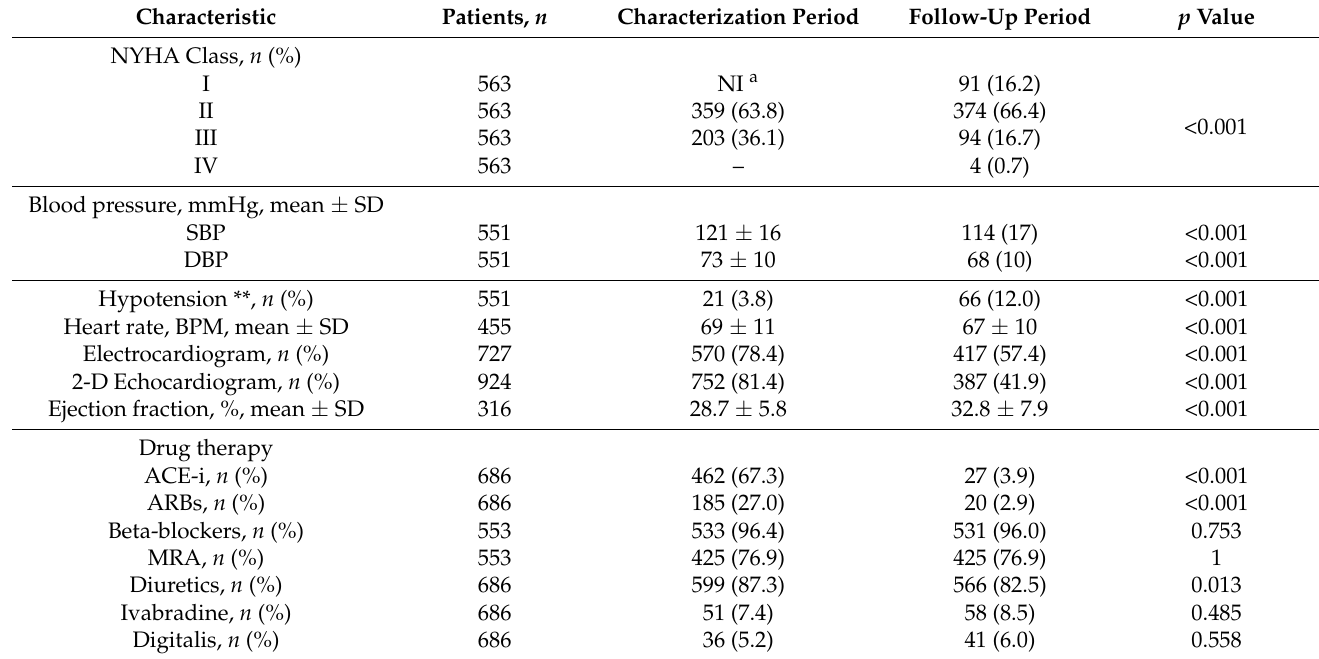
Table 2. Clinical examinations in patients with available data during characterization and follow-up periods